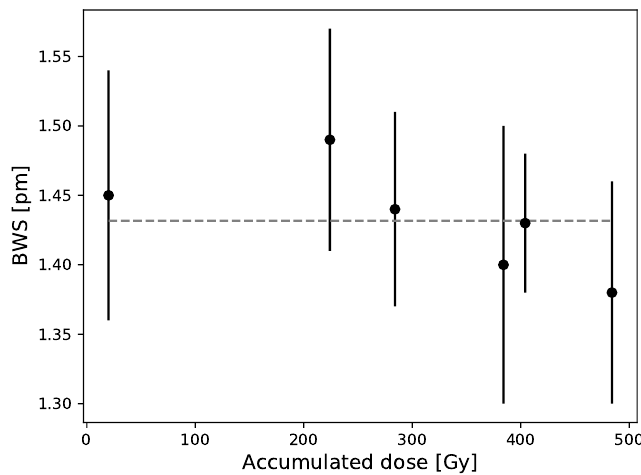
Figure 6. Bragg wavelength shift in terms of accumulated dose is measured throughout several months using a PMMA plate as coating (5.5 × 107.5 × 205 mm 3 ) and a 6 MV beam. Each point is the mean and standard deviation of 7 FBGs shift for a 20 Gy irradiation and the dash line is the overall mean.